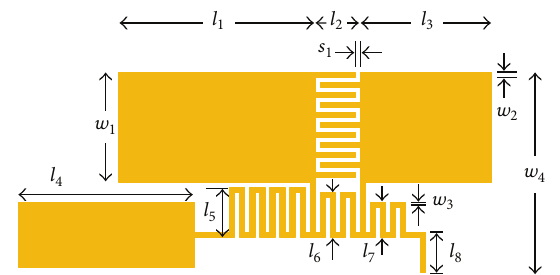
Figure 6: Modified asymmetric artificial transmission